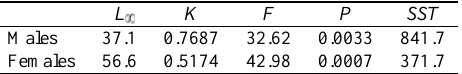
Table 3. Parameters estimated for the von Bertalanffy model using non-linear procedure ( L = asymptotic length (cm), k = growth rate (year -1 ), F = Fisher Statistic, P = level of significance, SST = sum of the corrected total squares) for S.